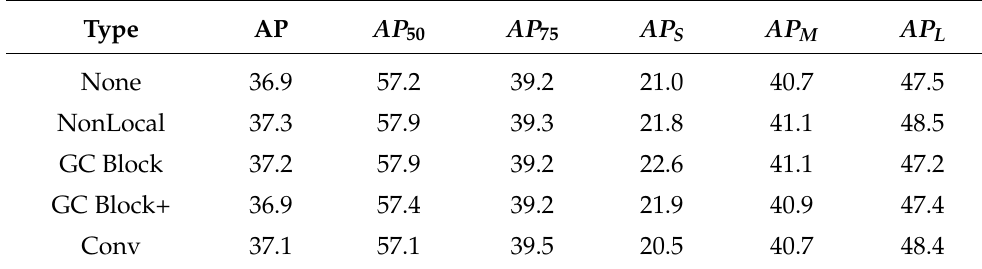
Table 5. Ablation studies of refine method on COCO